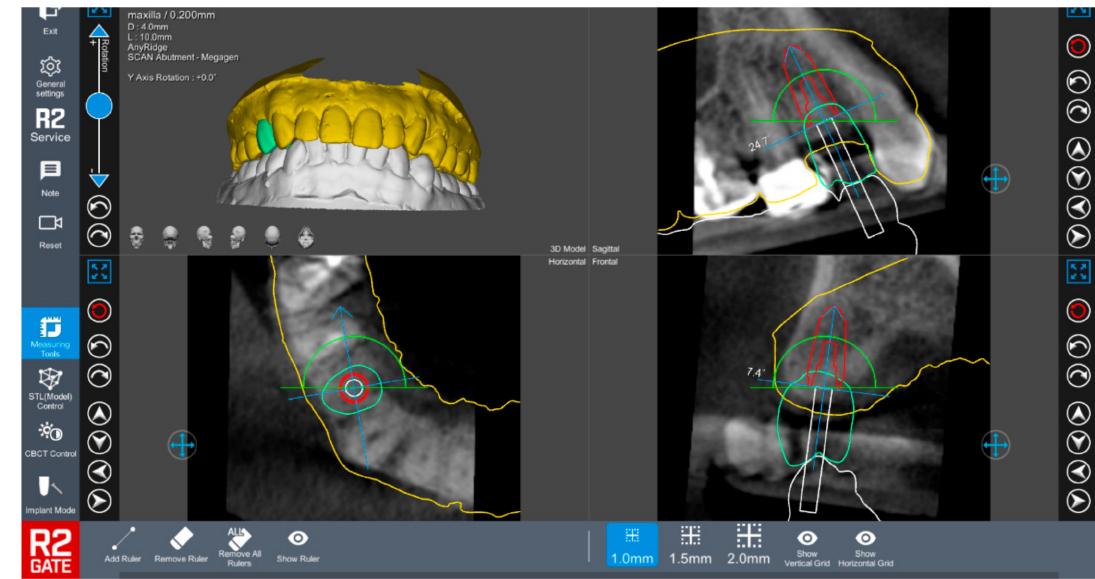
Figure 2. Virtual implant planning utilizing specialized software in which the dental surgeon preplans the surgical implant site using a specialized software to allow precise implant placement prior to the surgery. The figure shows a planned implant placement using R2 Gate™ (R2 Gate, Megagen, South